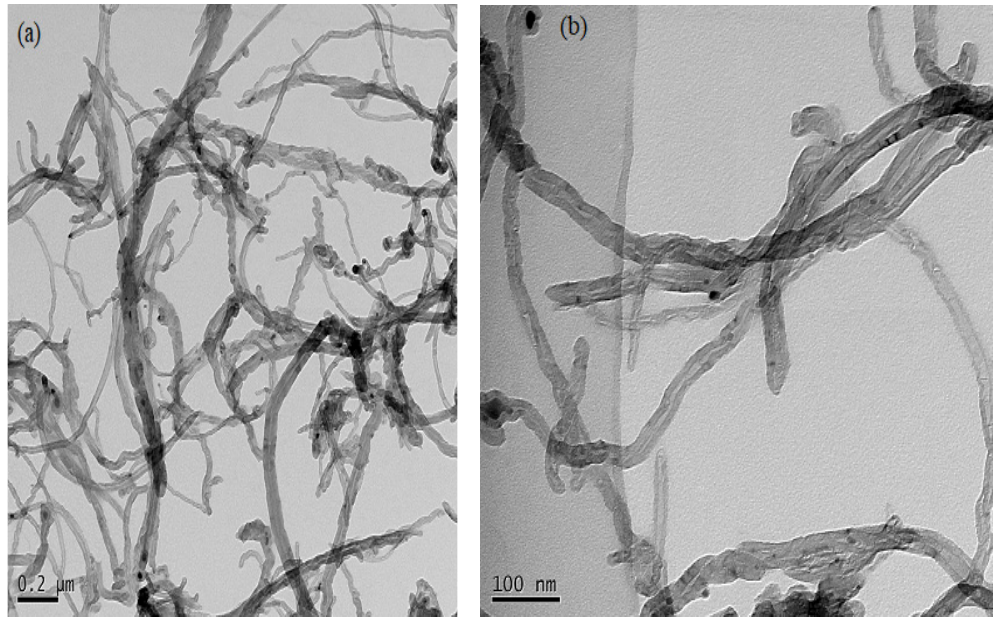
Figure 12. Scanning electron micrographs of synthesized CNTs at different magnifications mentioned on each subfigure ( a – c ).